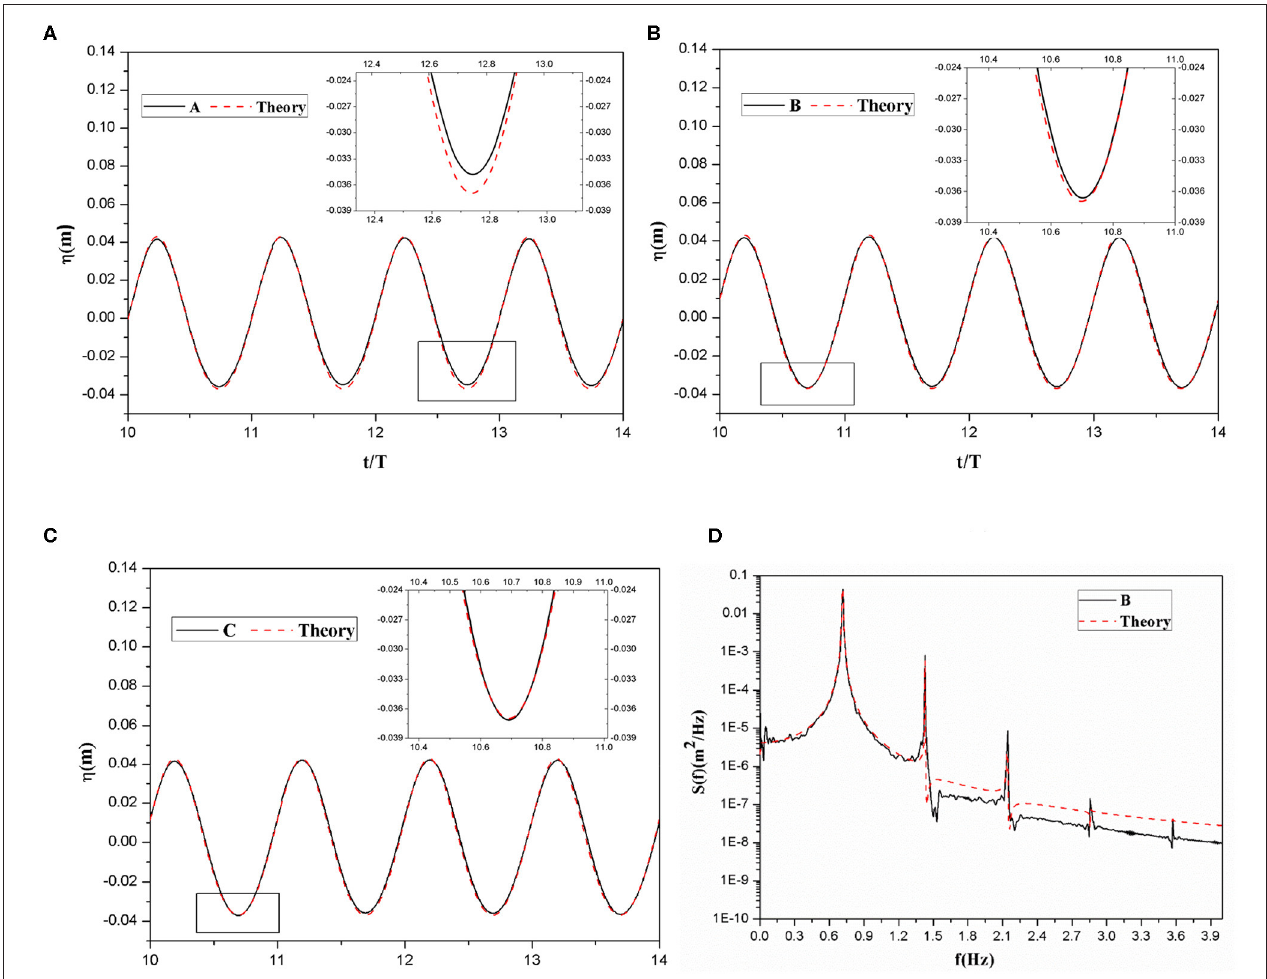
FIGURE 4 | Comparison of wave elevation measured from the numerical tank and theoretical values: (A) scheme A; (B) scheme B; (C) scheme C; (D) Spectrum of scheme